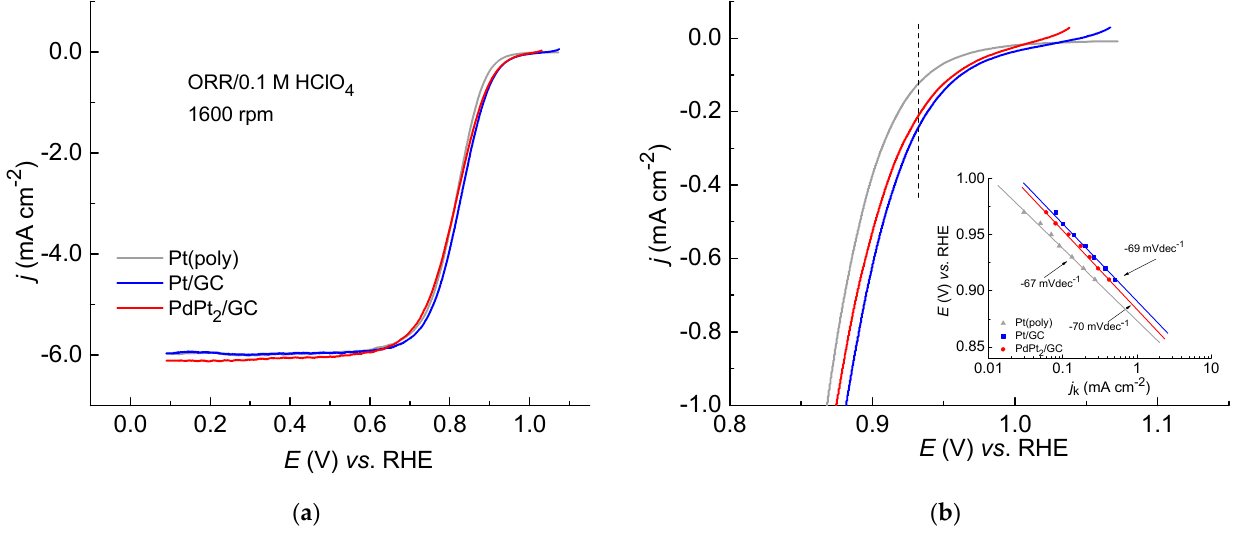
Figure 8. Comparison of the polarization curves for ORR on PdPt 2 /GC, Pt/GC, and Pt(poly) electrodes in 0.1 M HClO 4 : ( a ) Current densities are given with respect to the geometric area of the GC electrode; ( b ) Current densities in the activation control region are given with respect to the ECSA; insert shows corresponding Tafel plots.